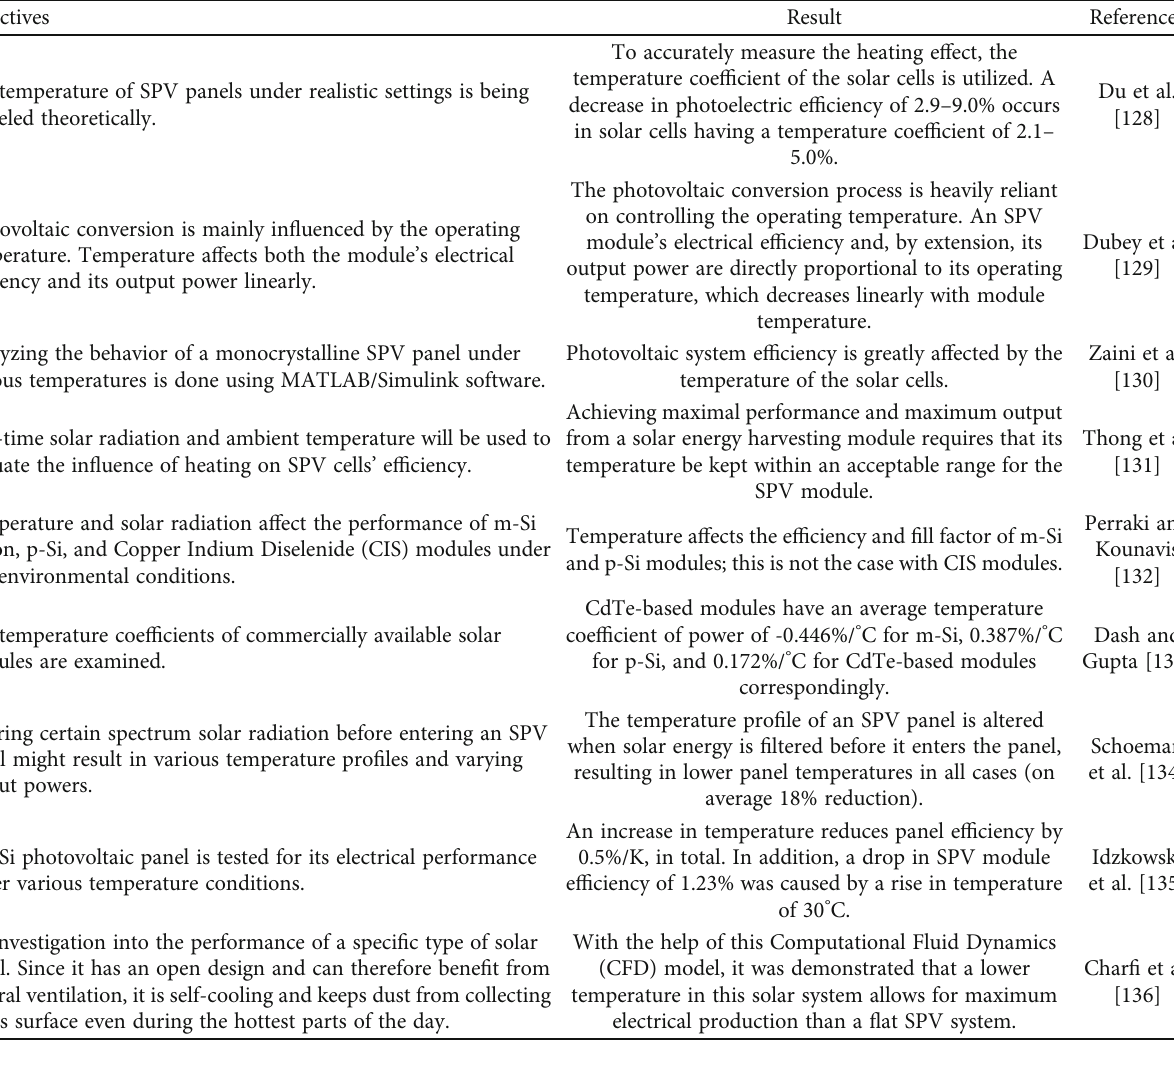
Table 3: Studies on the e ff ect of temperature.